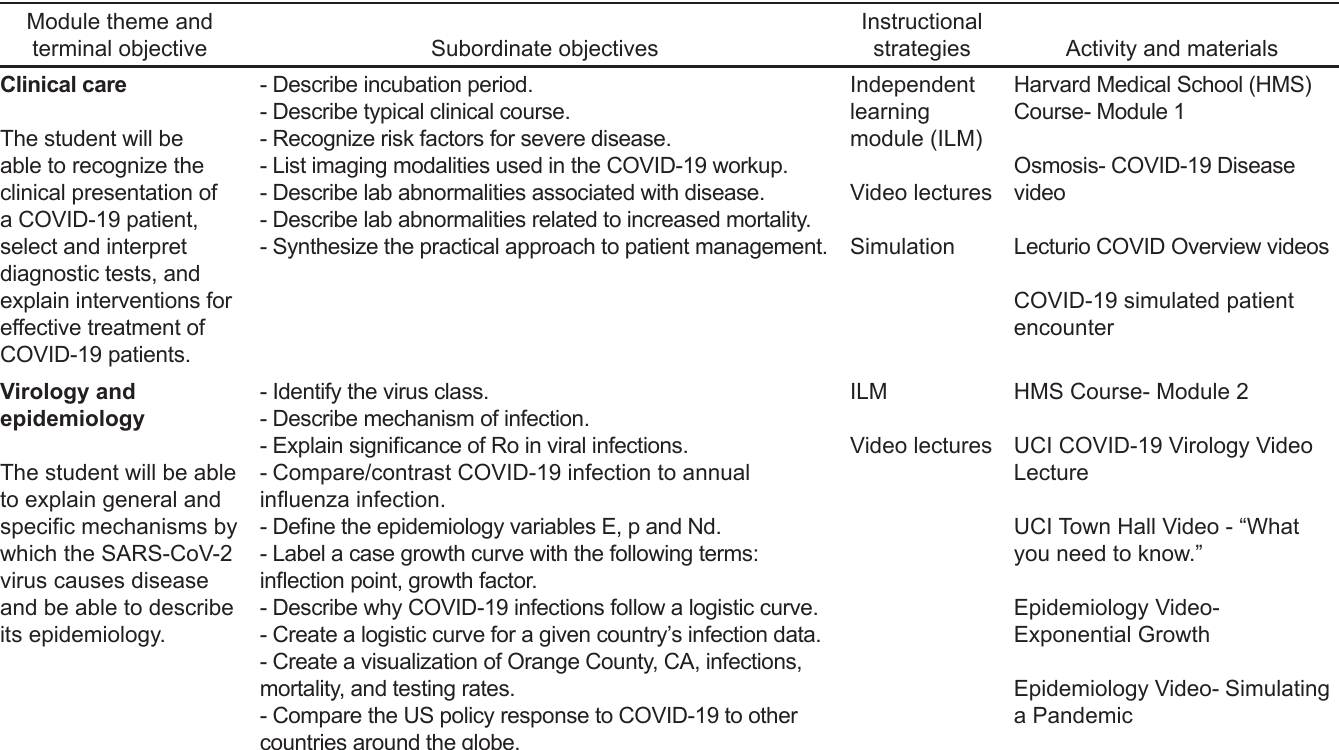
Table 1. Detailed learning module themes, module terminal objectives, subordinate objectives, instructional strategies, and activities.